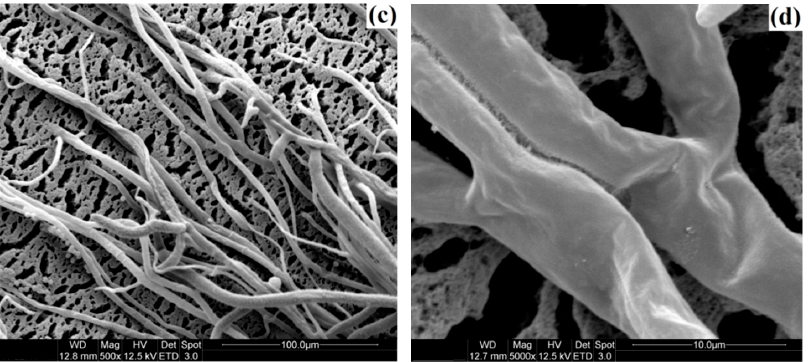
Figure 8. SEM images of normal cells (( a ) 500×; and ( b ) 5000×)) and cells on the edge of inhibition zone (( c ) 500×; and ( d ) 5000×) of A. flavus .